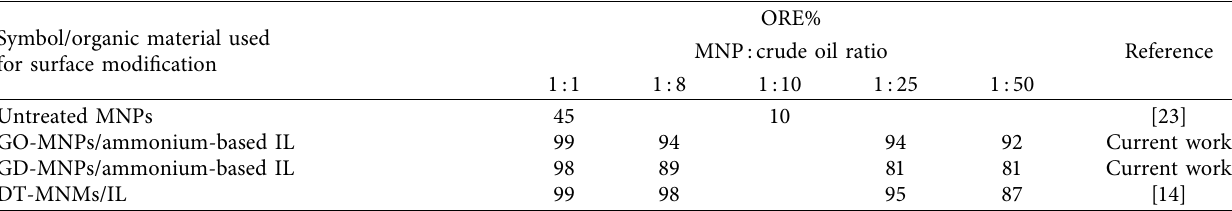
Table 1: Comparison between the ORE values of MNPs prepared in the current work, ORE values of untreated MNPs, and ORE values of surface-modifed MNPs using diferent organic materials. Symbol/organic material used for surface